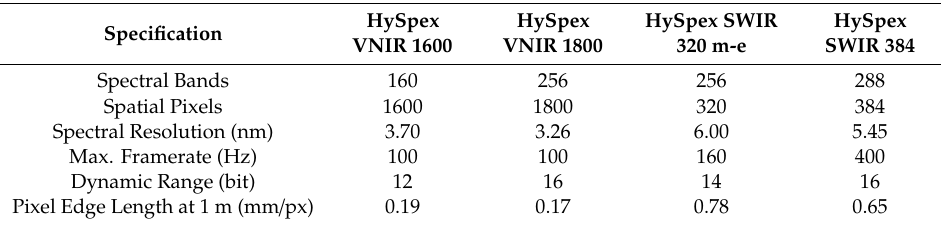
Table 4. Overview of the camera